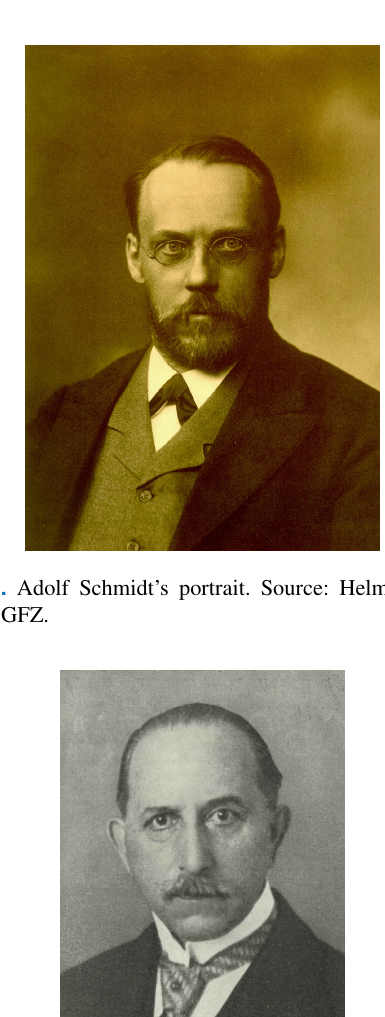
in 1901 at an age of only 43 years after serious